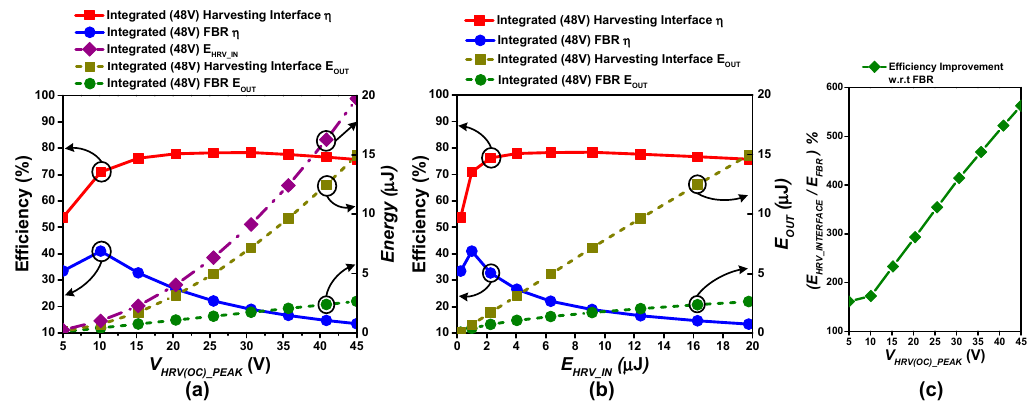
Figure 16. ( a , b ) E ffi ciency comparison between the FBR and the proposed harvesting interface with integrated power switches at harvester open circuit voltage and input energy on x-axis respectively when harvesting from MIDE V22B piezoelectric harvester source (C P = 19.5 nF) under periodic excitation at 3.3 V battery charging, ( c ) Energy extraction improvement w.r.t FBR.